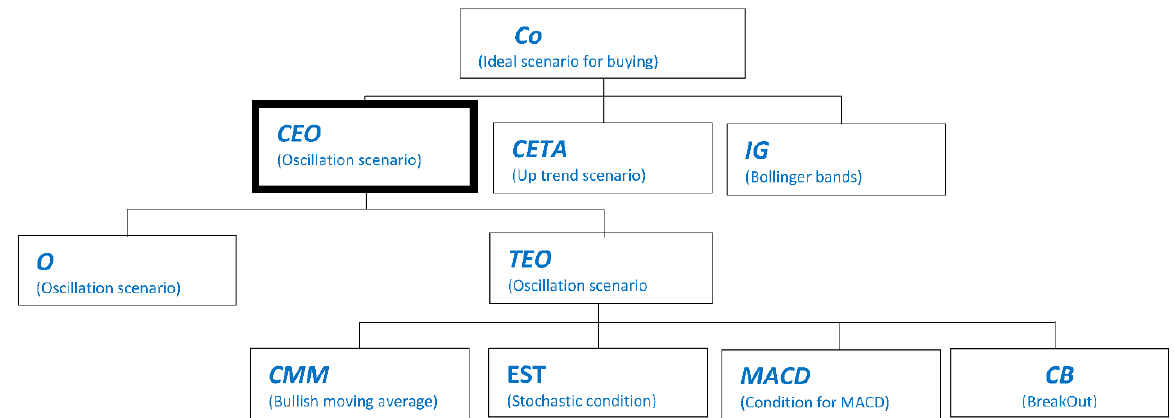
where  denotes implication. See Figure 2.